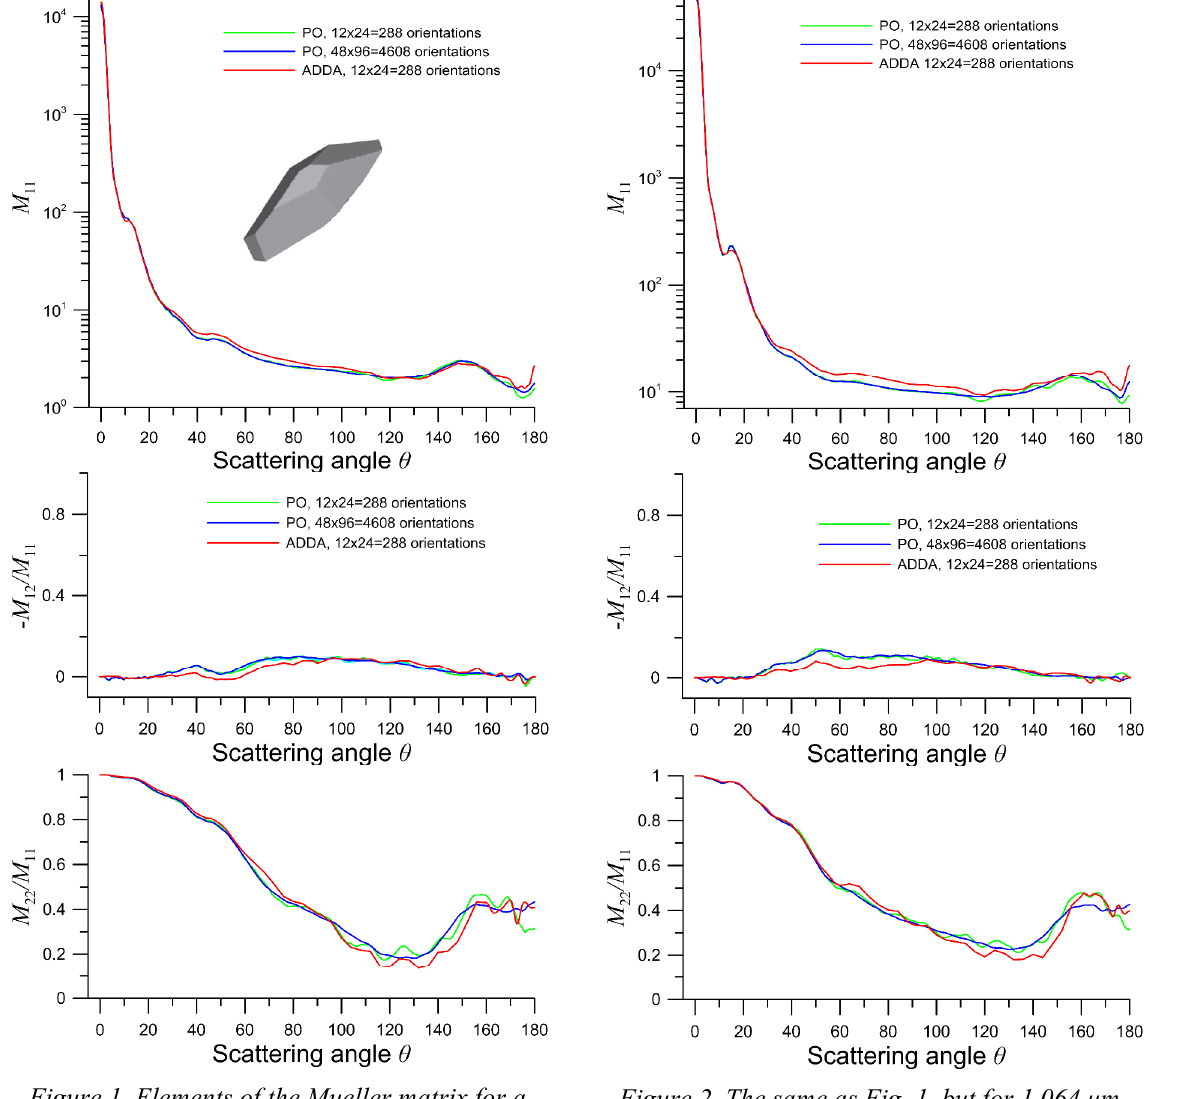
Figure 2. The same as Fig. 1, but for 1.064 μ m. Generally speaking, with a doubling in size it is necessary to increase the number of orientations four times. Therefore, the calculation for size x = 200 requires 115200